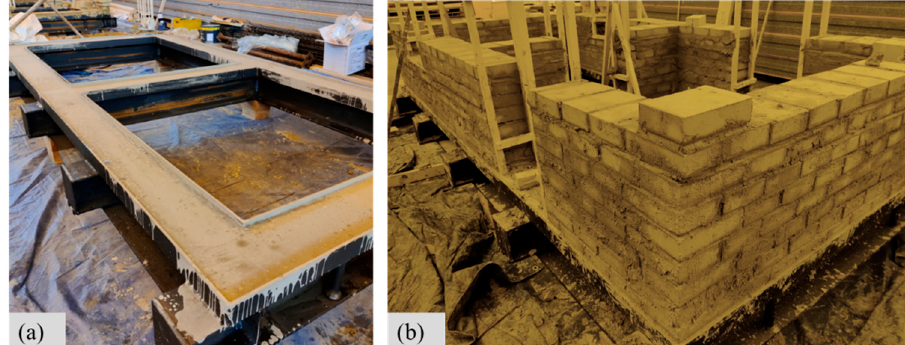
Figure 3. ( a ) Plain concrete cast on the metallic frame; ( b ) bricklaying for the building model.